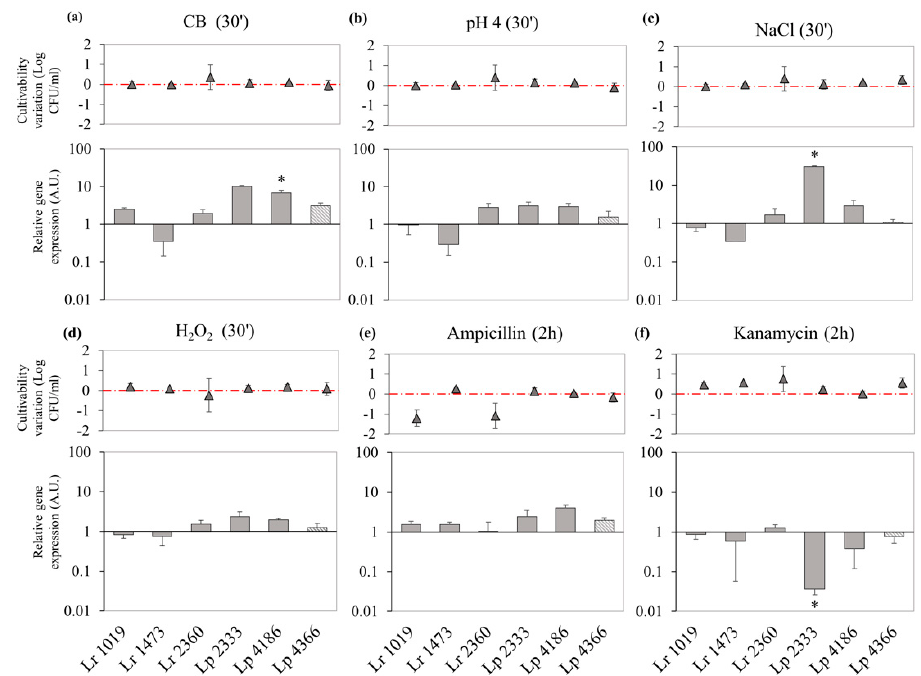
Figure 5. Relative expression of DinJ-YafQ transcript in L. paracasei (Lp) and L. rhamnosus (Lr) strains in response to food-related stress conditions, and exposure to antibiotics. The upper panels describe, for each strain, the culturability variation reported as the difference between the value measured under the stress condition and that measured in the control condition (grey triangles). The bar graph below reports relative gene expression calculated using 16S rRNA as a reference gene (gray bars), except for L. paracasei 4366 samples that were normalized using gyrB as a reference gene (striped gray bars). For all the strains gene expression was normalized against the control condition, that is not reported. ( a ) nutritional stress, ( b ) acidic stress, ( c ) osmotic stress, ( d ) oxidative stress, ( e ) exposure to ampicillin, ( f ) exposure to kanamycin. Error bars represent the SEM ( n = 2). * significant difference, p < 0.05.